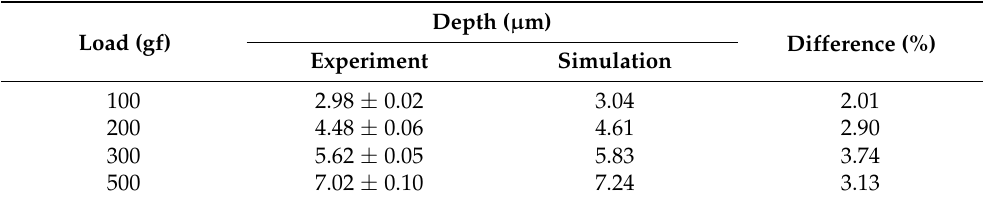
Table 9. Comparison of experimental (Table 2) and the corresponding simulation plastic indentation depth results of the Ti-6Al-4V substrates for different load cases.